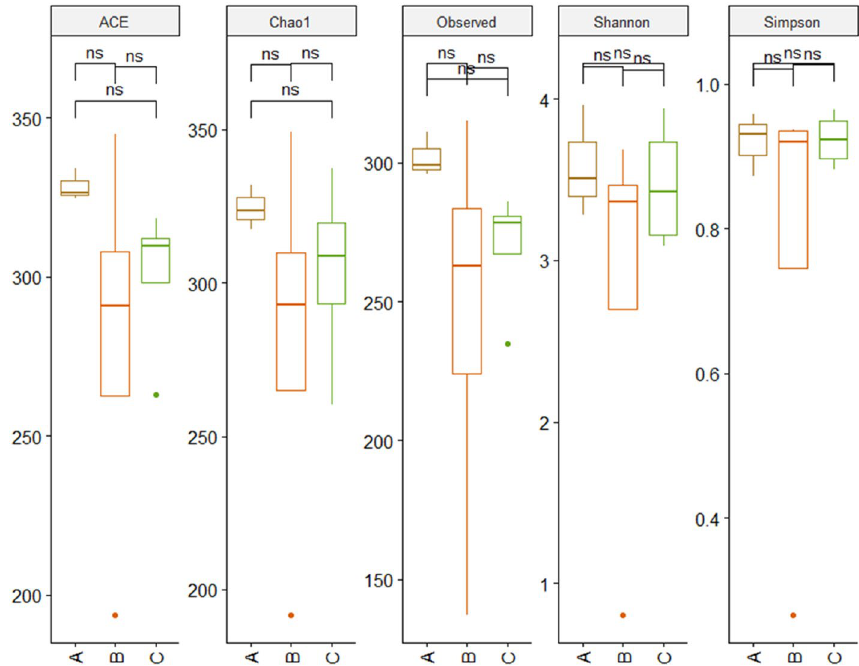
Figure 3. Comparison of different alpha diversity indices (ACE, Chao1, observed OTUs, Shannon and Simpson) between study groups shows no significant